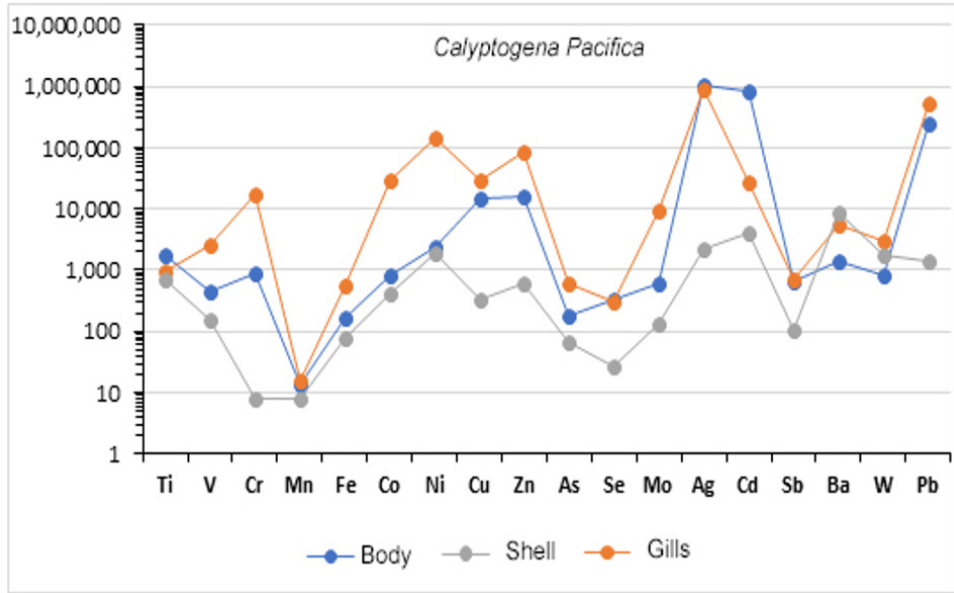
Figure 13. Distribution pattern of the trace element BCF in gills, the rest of soft body, and shell of C. pacifica